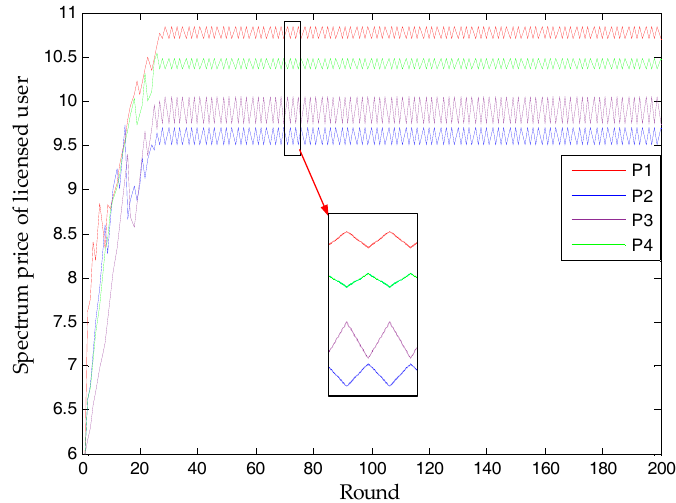
Figure 12. The existence of several subgame-perfect equilibria.